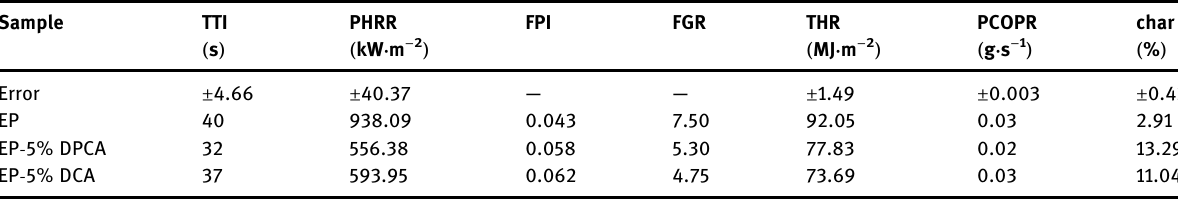
Table A2: The cone calorimeter data of EP and its composites